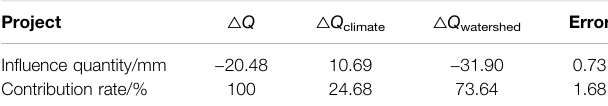
TABLE 3 | Relative contribution rates of climate change and watershed characteristic changes to stream fl ow variability. Project △ Q △ Q climate